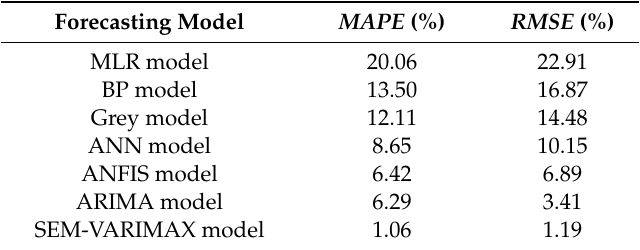
Table 4. Performance monitoring of the forecasting